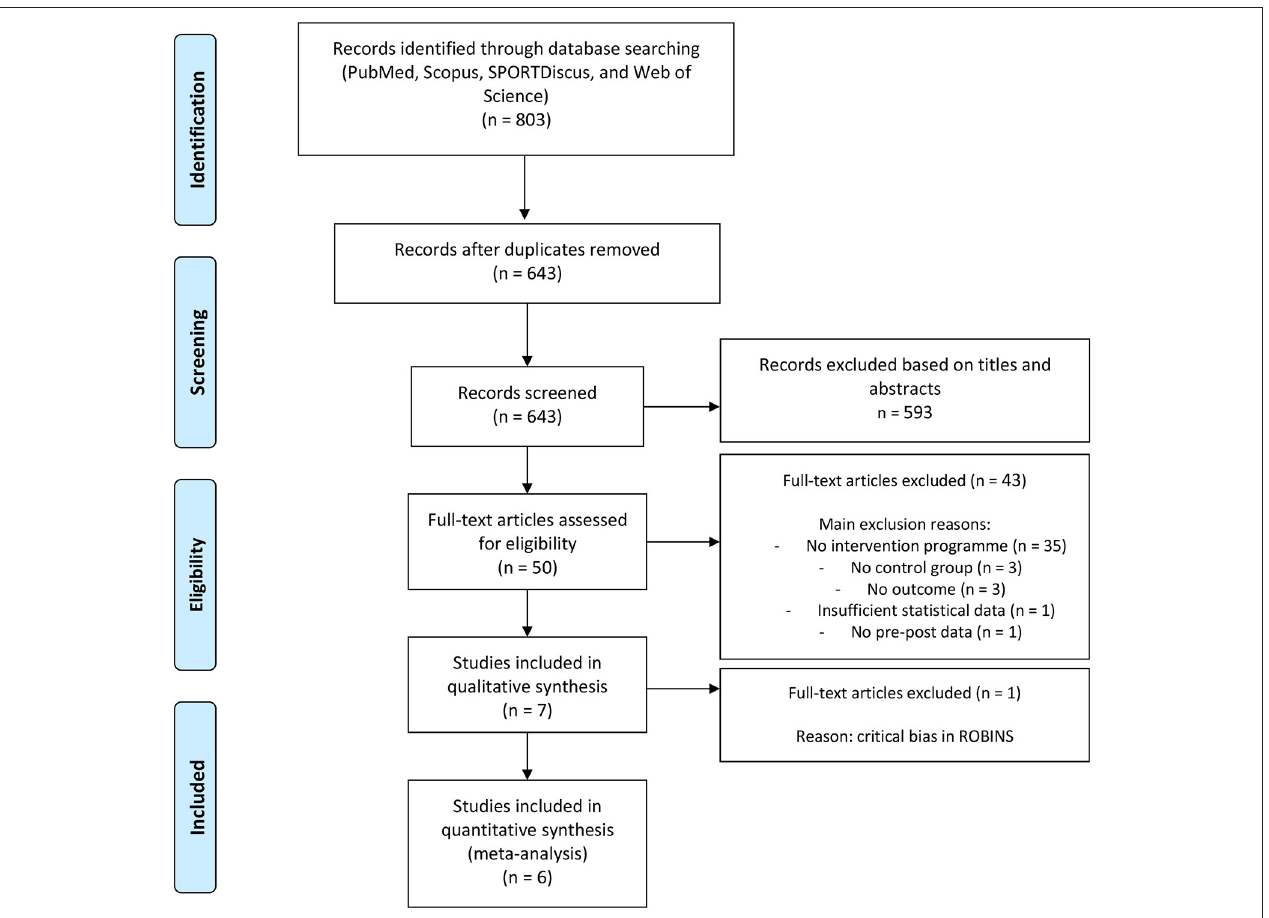
FIGURE 1 | PRISMA flow diagram highlighting the selection process for the studies included in the current systematic review.